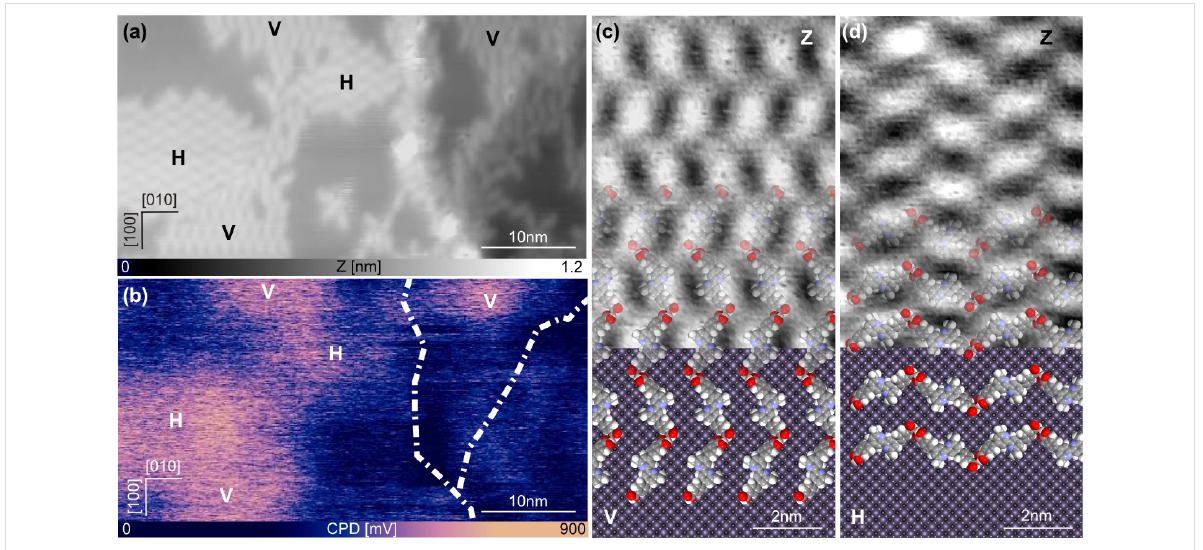
Figure 5: Islands of DCPDMbpy on NiO(001). (a, b) simultaneous topographic and CPD measurements of the molecular islands (V and H) on the NiO(001) substrate, respectively. (c, d) Close-up on both types of islands. In the lower parts qualitative models of the substrate and the molecular arrangement are overlayed. (Scan parameters: = 4 nm; Δ f 1 = − 9 Hz; f ac = 900 Hz; V ac = 800